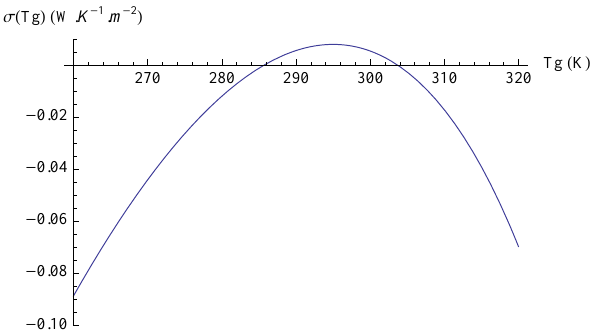
Fig. 7. Entropy production rate as a function of the surface tem- perature T g for the 0D model at S = S 0 . The only local maximum corresponds to T g ≈ 295K.